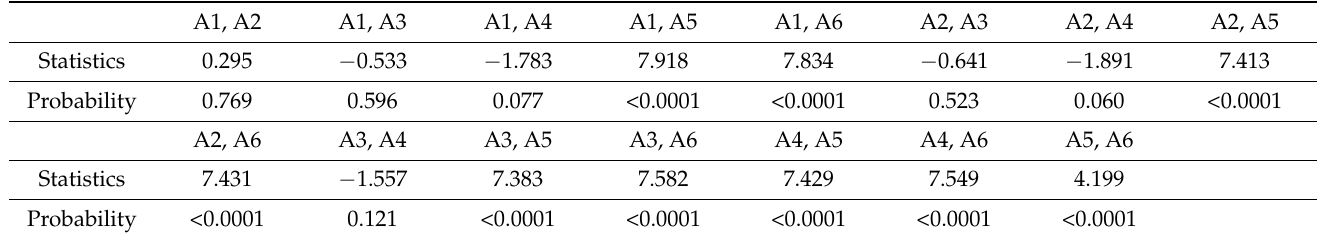
Table 8. Comparison of different models using the Diebold–Mariano Test.